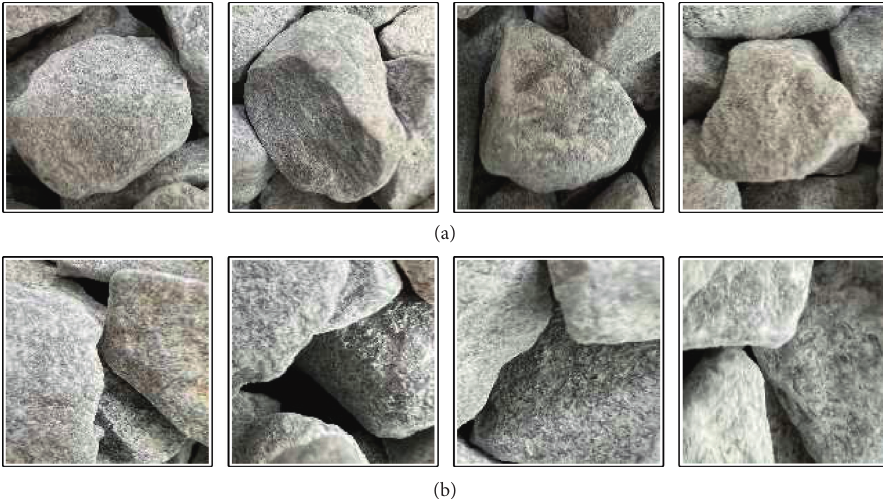
Figure 2: (a) Samples of positive images; (b) samples of negative images.